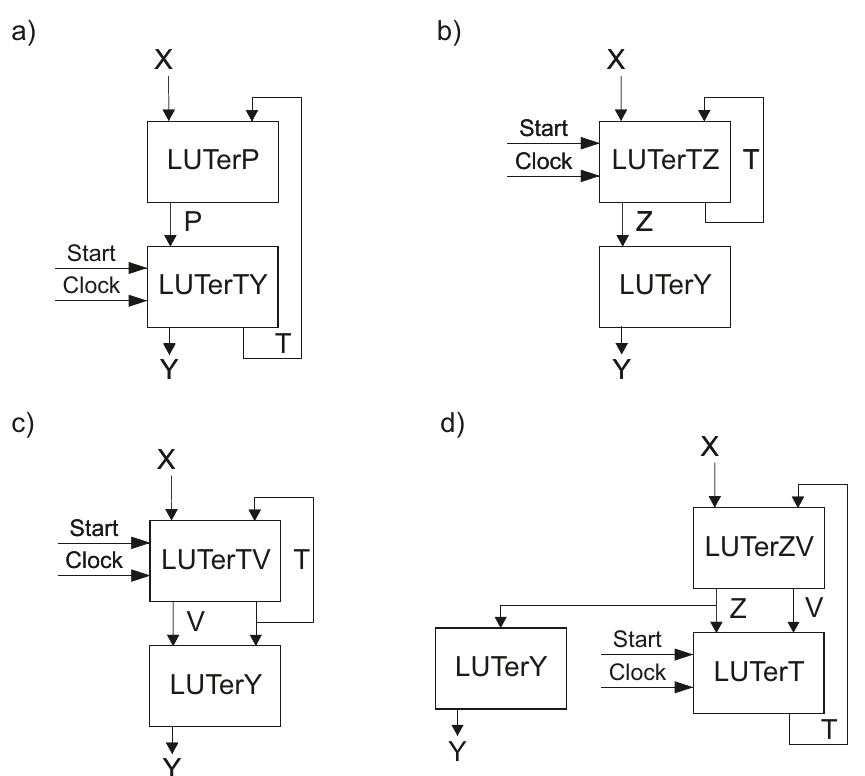
Figure 12. Structural diagrams of LUT-based Mealy FSMs with two-levels of logic: ( a ) replacement of inputs; ( b ) encoding of collections of outputs; ( c ) transformation of state codes into outputs; ( d ) transformation of collections of outputs into state codes.